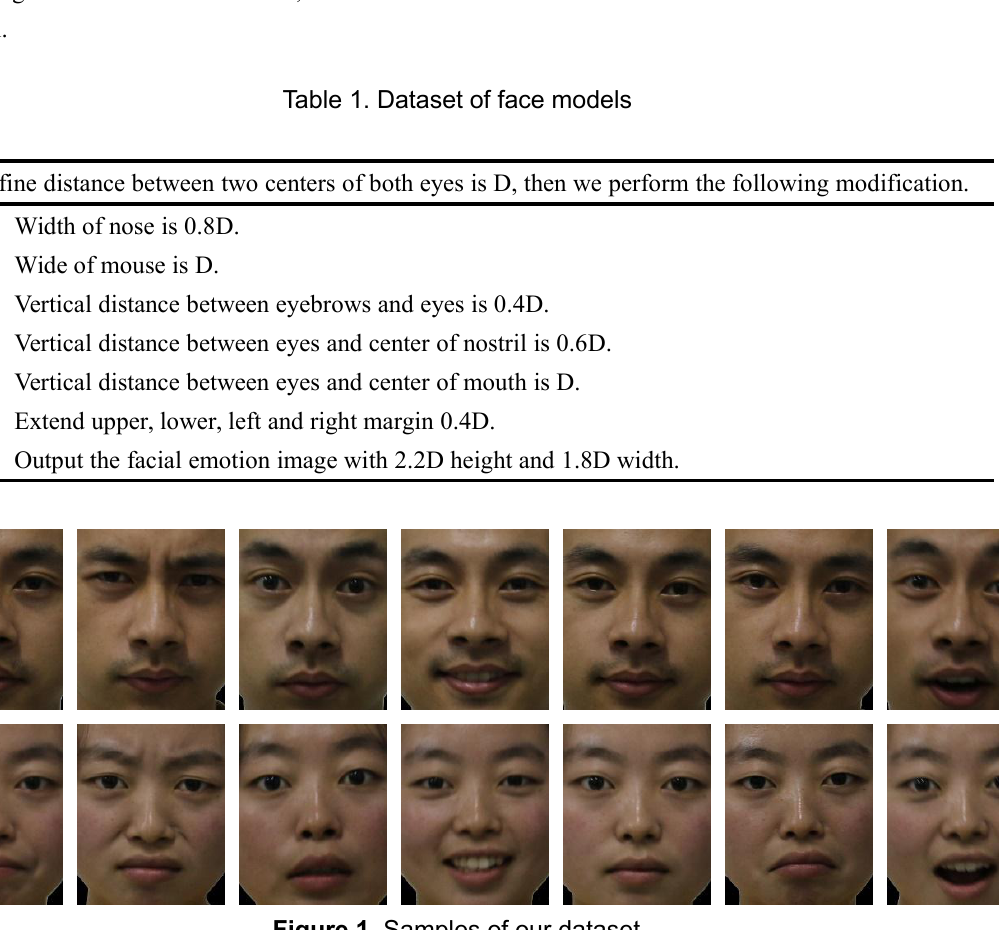
Figure 1. Samples of our